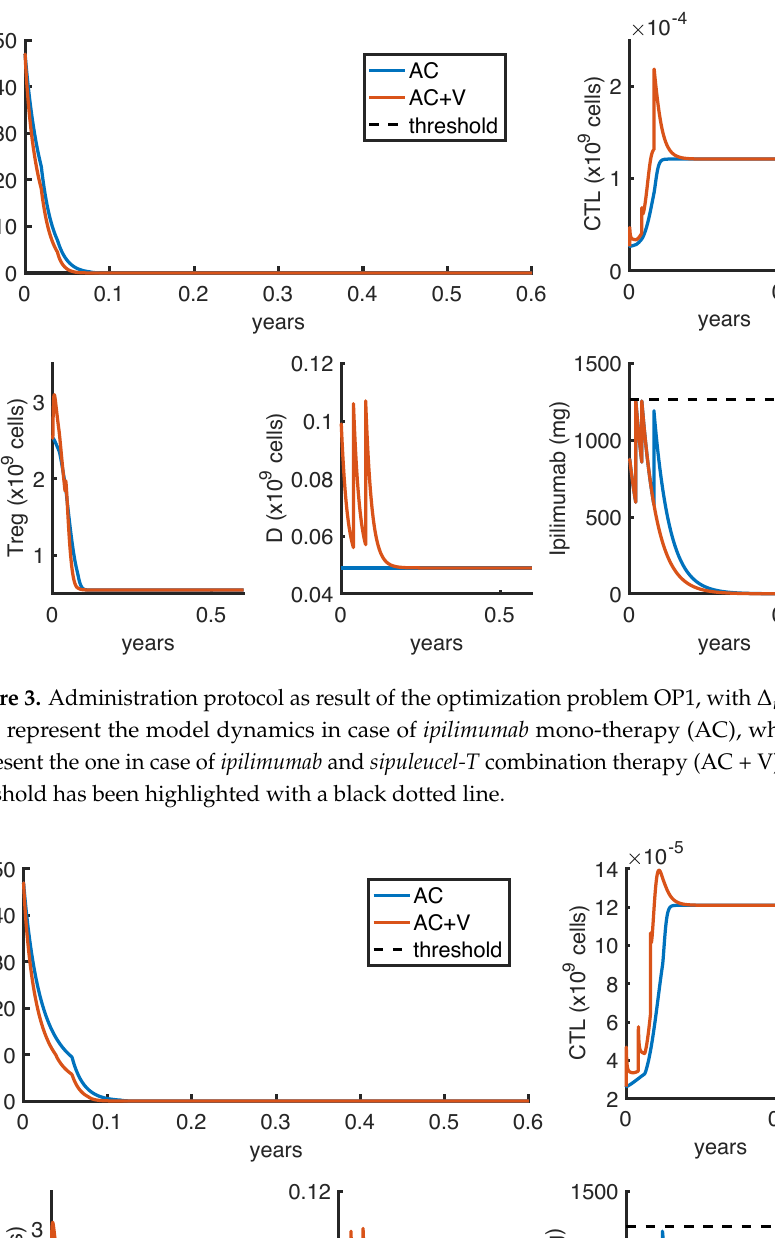
- Table 3: Parameter estimates of the toxicity function in equation (4). 3.2. Optimal administration protocols 230